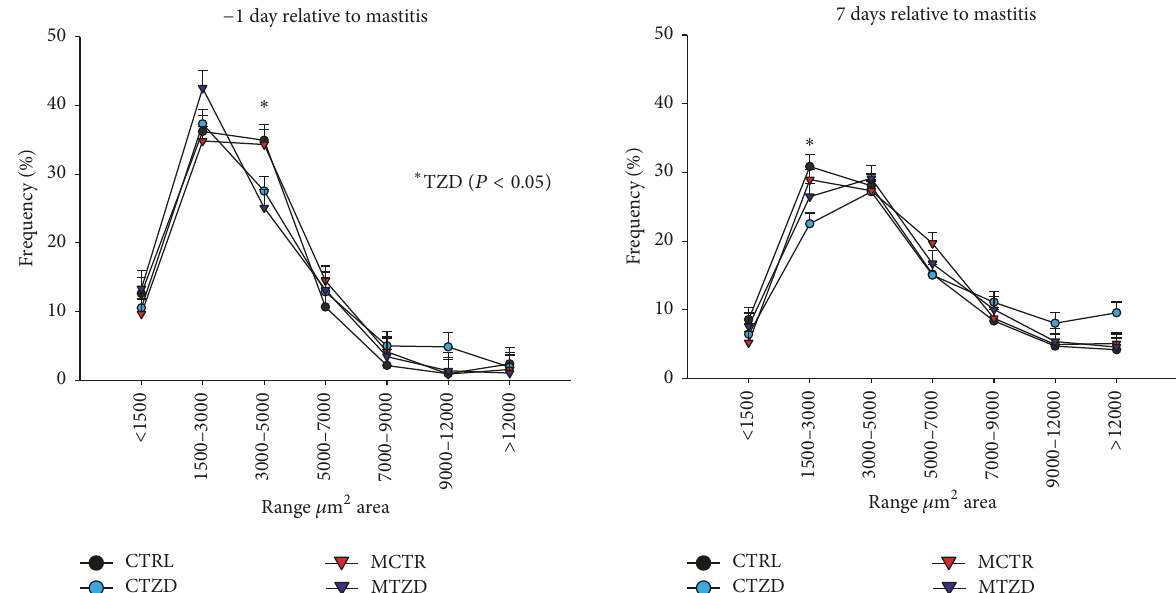
Figure 12: Frequency of adipocytes in subcutaneous adipose tissue collected from the tail-head of goats receiving intramammary infusion (IMI) of Strep. uberis (M) or saline plus daily intrajugular injection of 2,4-thiazolidinedione (TZD) or saline (CTR). Significant difference due to TZD is indicated by ∗